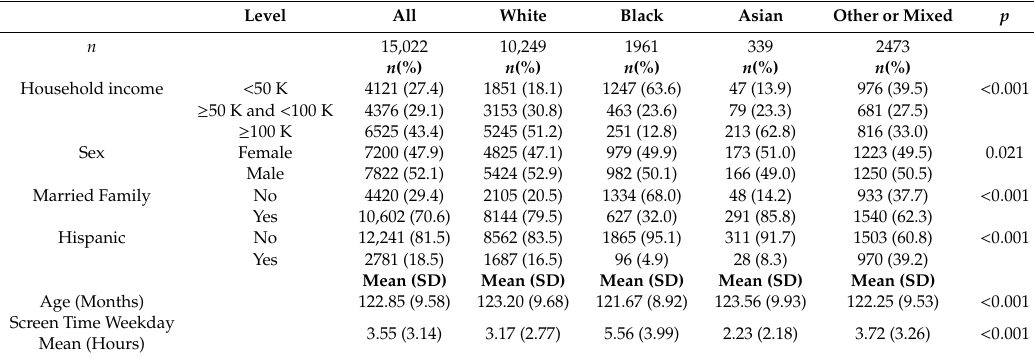
Table 2. Descriptive characteristics by race ( n =